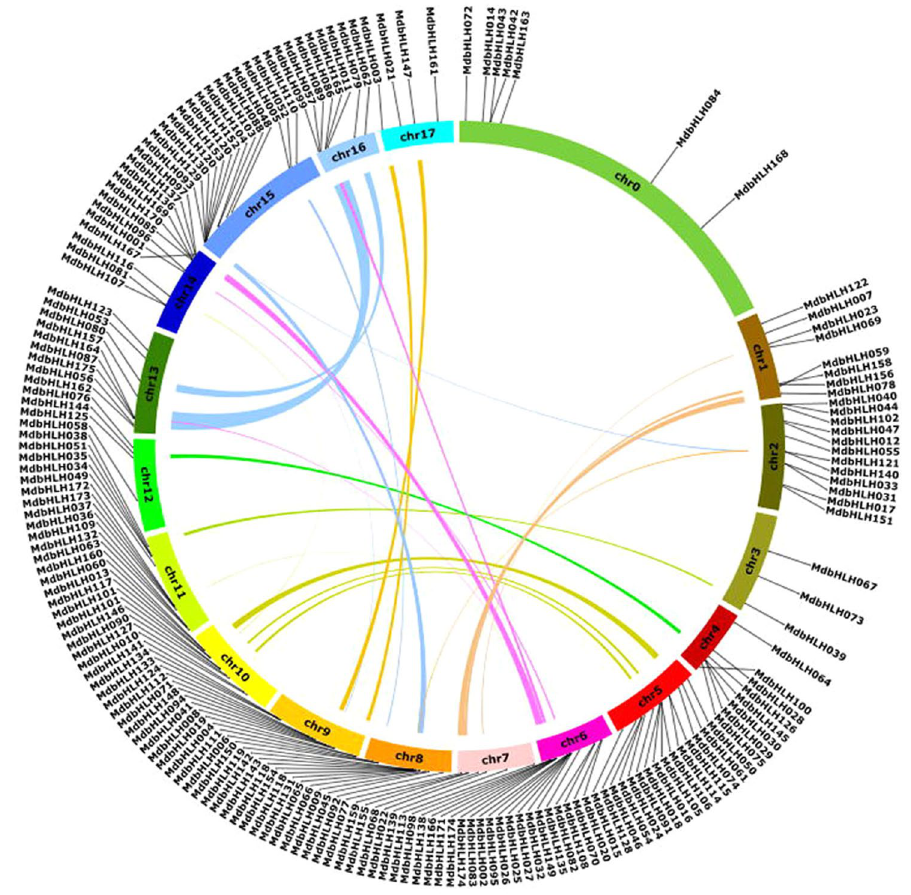
Figure 4. Distribution and synteny analysis of MdbHLH genes on the apple ( Malus × domestica ) chromosomes. The locations of the apple bHLH genes are indicated by vertical black lines. Colored bars connecting